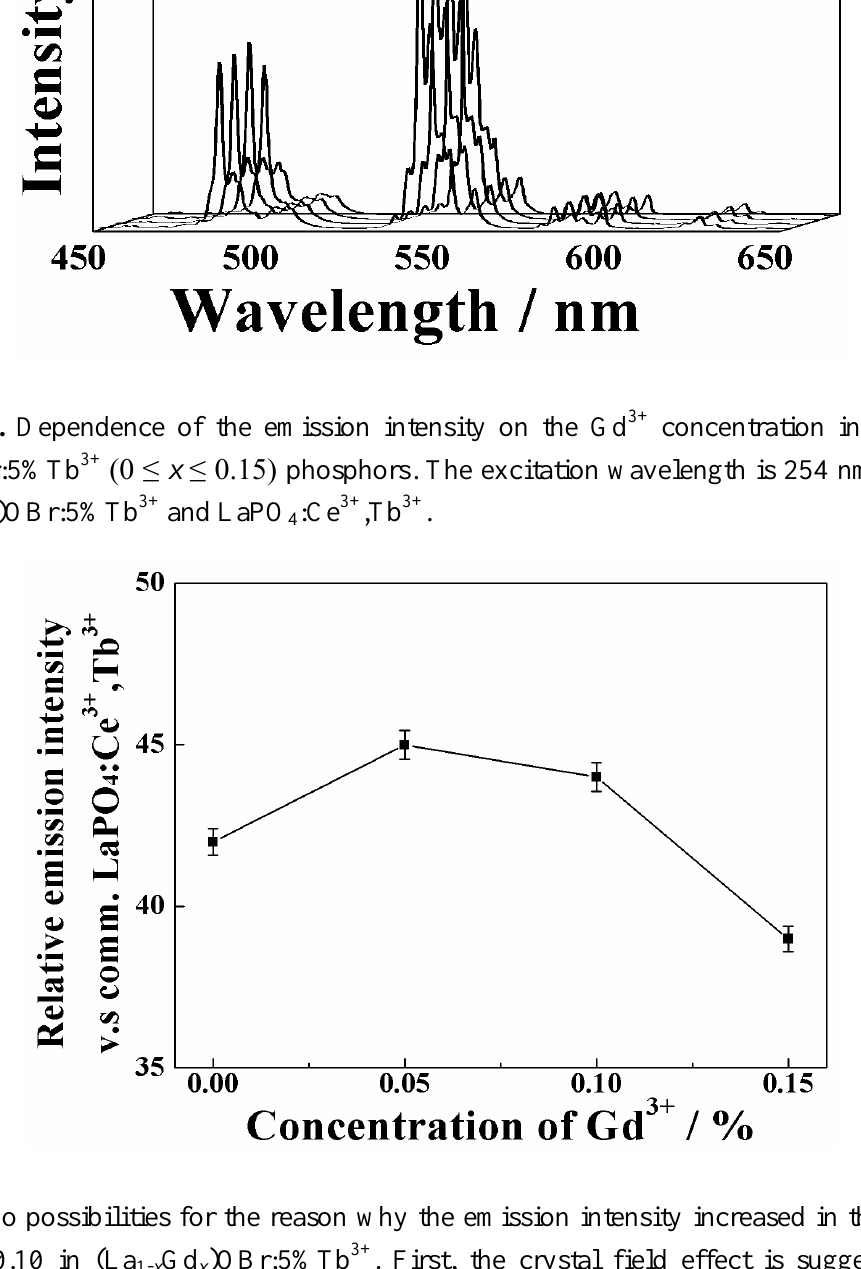
Figure 5. Emission spectra of the (La 0.10, and (d) 0.15.